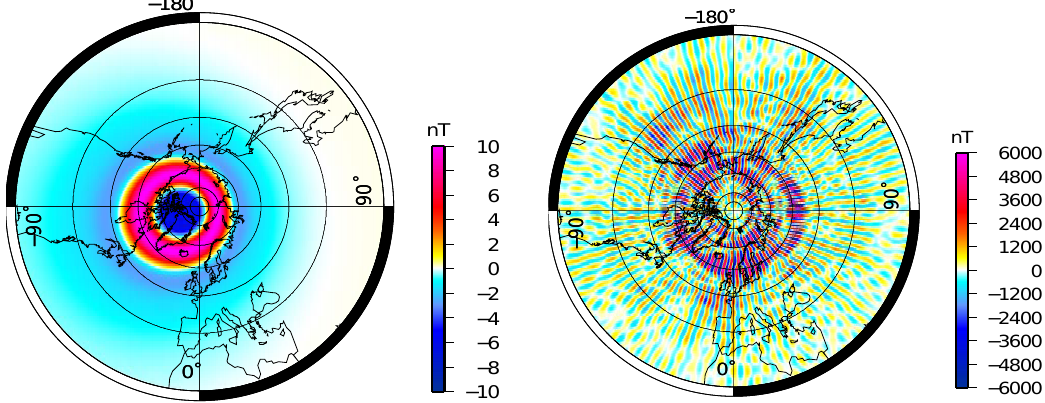
Fig. 3. Mapping at r 0 = 6371 . 2km of the field of internal origin (left) and the resulting noise model (right). The data acquisition radius has been set to r = 6671 . 2km – i.e. 300km altitude – and the random variables χ k m have the variances defined in Table 1 with the ratio v to